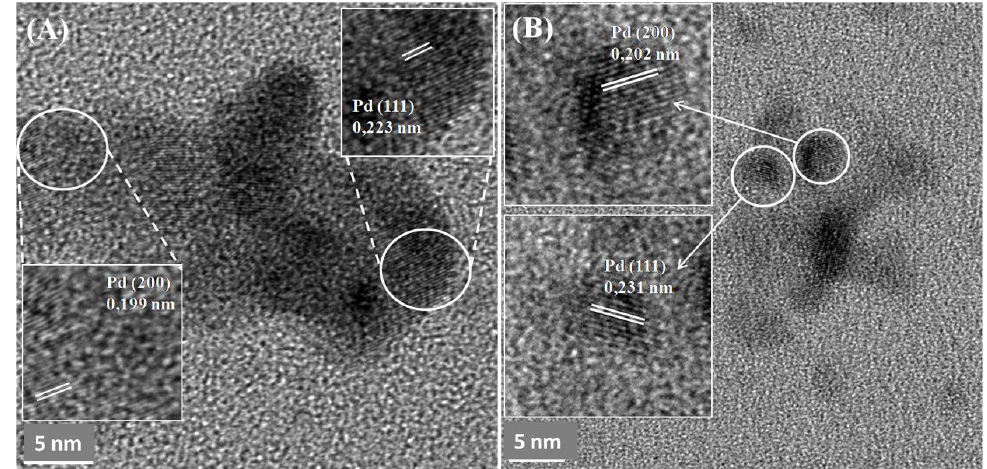
Figure 7. TEM images of membrane-bound Pd crystals made by D. desulfuricans 5% bio-Pd 30 seconds MW treatment before being exposed to Pd(II) ( A ) and untreated cells ( B ) revealing lattice spacing in